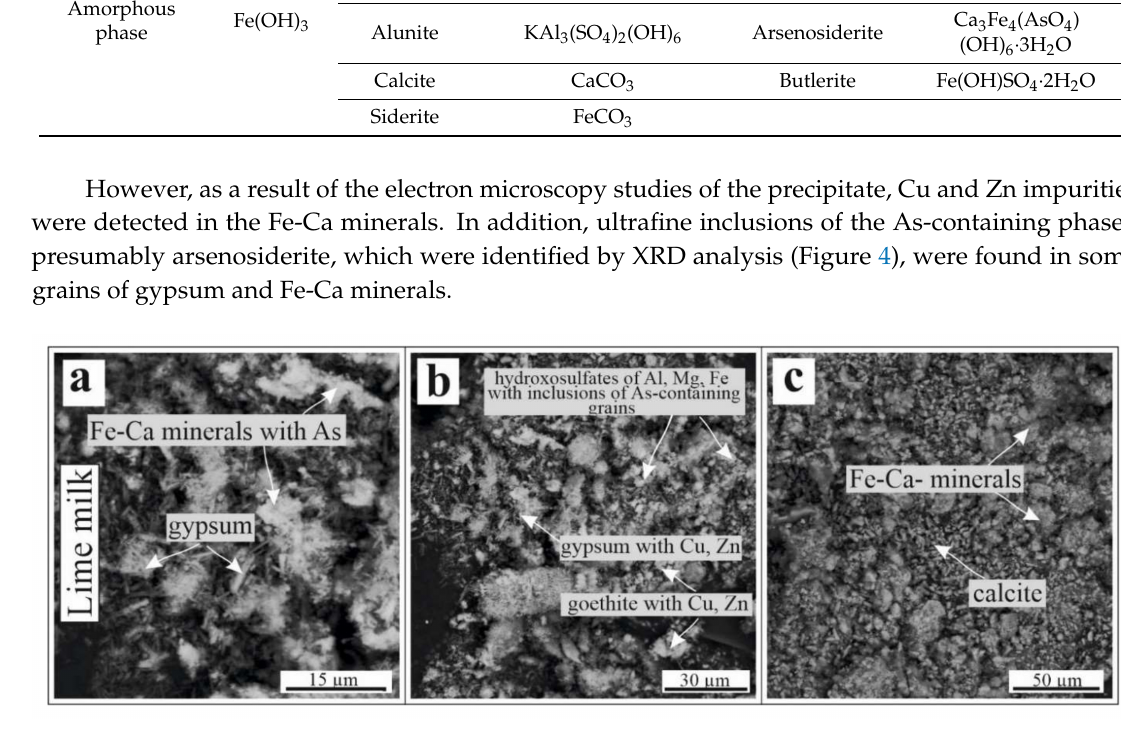
Figure 4. Scanning electron microscopy images of the precipitates after the experiments with Ca(OH) 2 : ( a ) fine-grained crystals of gypsum in the groundmass of Fe-Ca minerals containing As (possibly arsenosiderite); ( b ) colloform mixture of gypsum, goethite, and hydroxosulfates of Al, Mg, and Fe, with ultrafine inclusions of As-containing grains. Cu and Zn were found as impurities in gypsum and goethite; ( c ) a mixture of Fe-Ca- minerals with